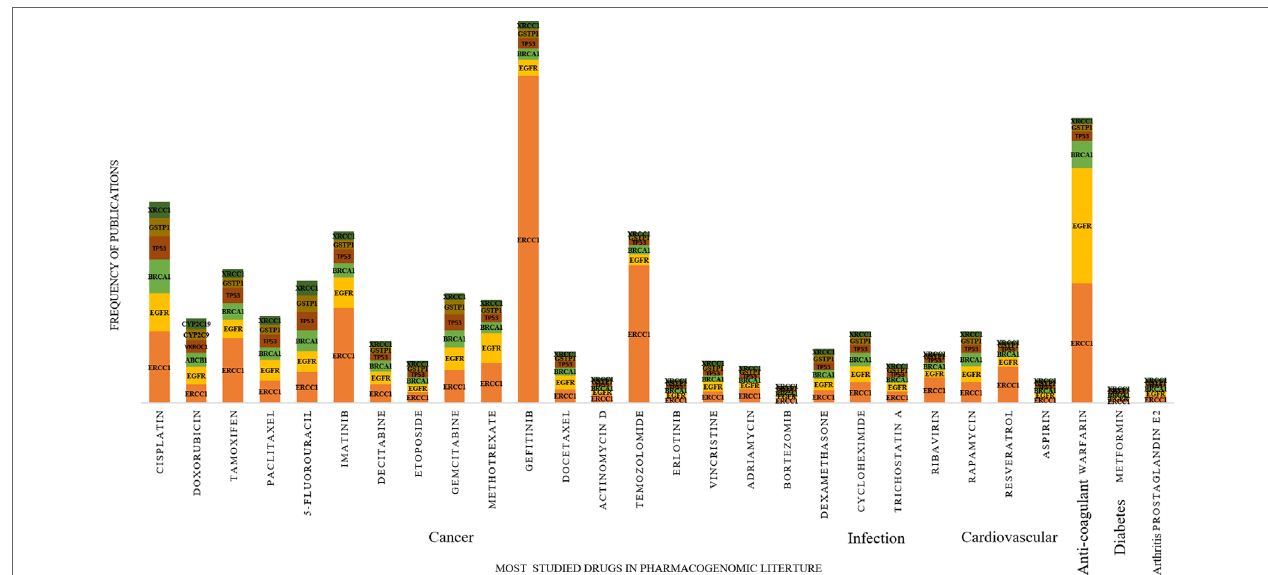
FIGURE 2 | Distribution of pharmacogenomic (PGx)-specific entities obtained from 2,304 PGx relationships with at least 100 citations. In the increasing order of the most prevalent medications prescribed from left to right and the most studied genes studied for PGx association with these